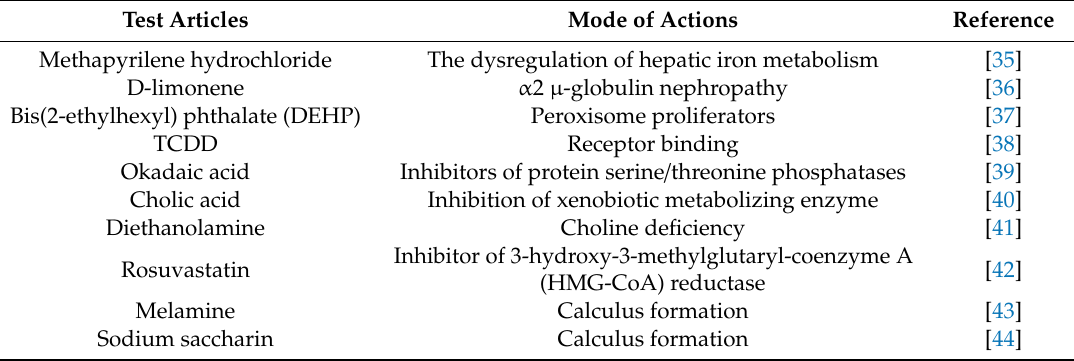
Table 2. Mode of actions of the test